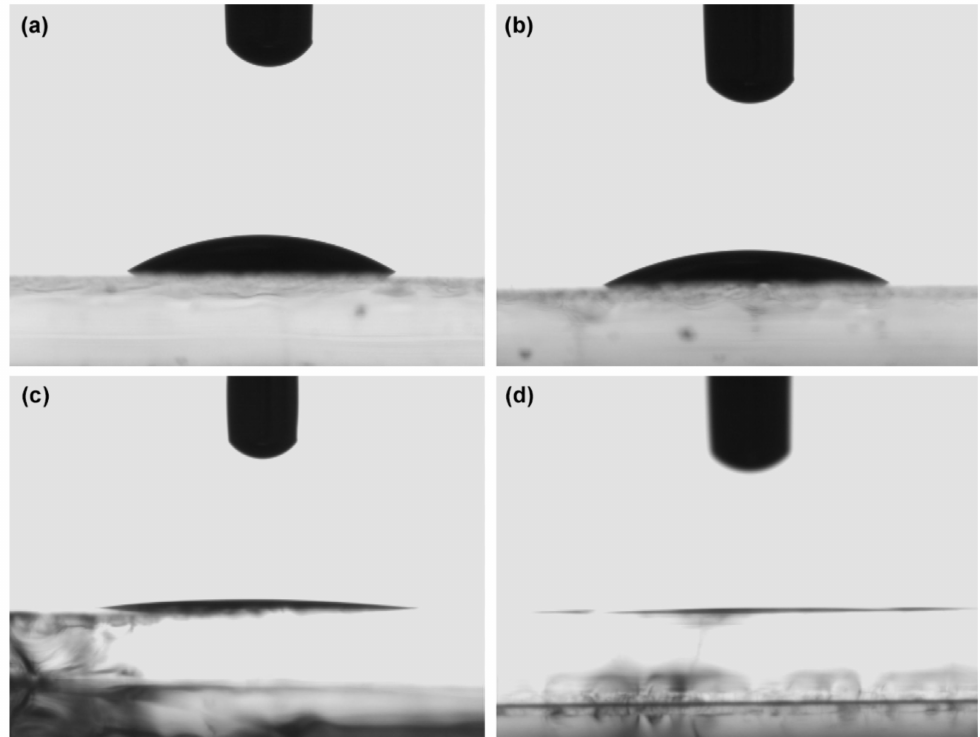
Figure 5. Contact angles of: ( a ) DMF/DMSO on glass, ( b ) PVP-DMF/DMSO on glass, ( c ) DMF/DMSO on ZnO seed layer, and ( d ) PVP-DMF/DMSO on ZnO seed layer.